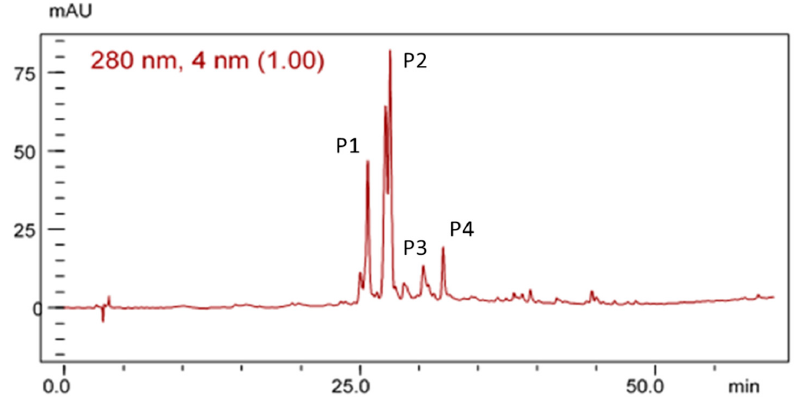
Figure 2. Chromatographic profile of the electrohyroalcoholic extract (EHE) of B. virgilioides under the conditions of exploratory gradient water/methanol (5–100%) in a 280-nm wave, Dos Santos [27].